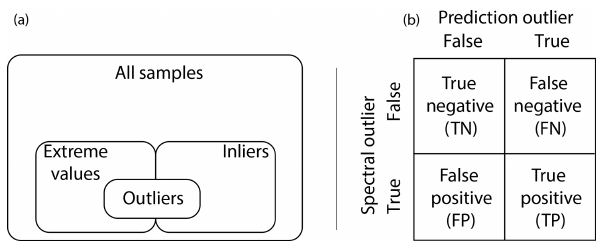
Figure 13. Venn diagram (not to scale, a ) and confusion matrix (b) depicting the relationship between detected outliers and magnitude of prediction